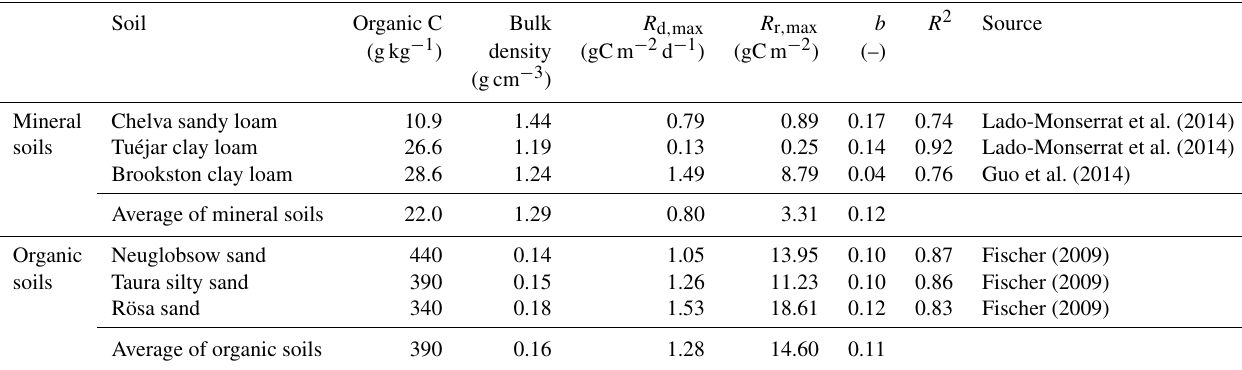
Table 2. Characteristics of the selected mineral and organic soil samples; estimates of the respiration model parameters in Eq. (13) ( R d , max : maximum respiration rate at the soil field capacity, R r , max : maximum respired carbon at rewetting) and coefficients of determination ( R 2 ) for the least-square fit of the data (see also Fig.